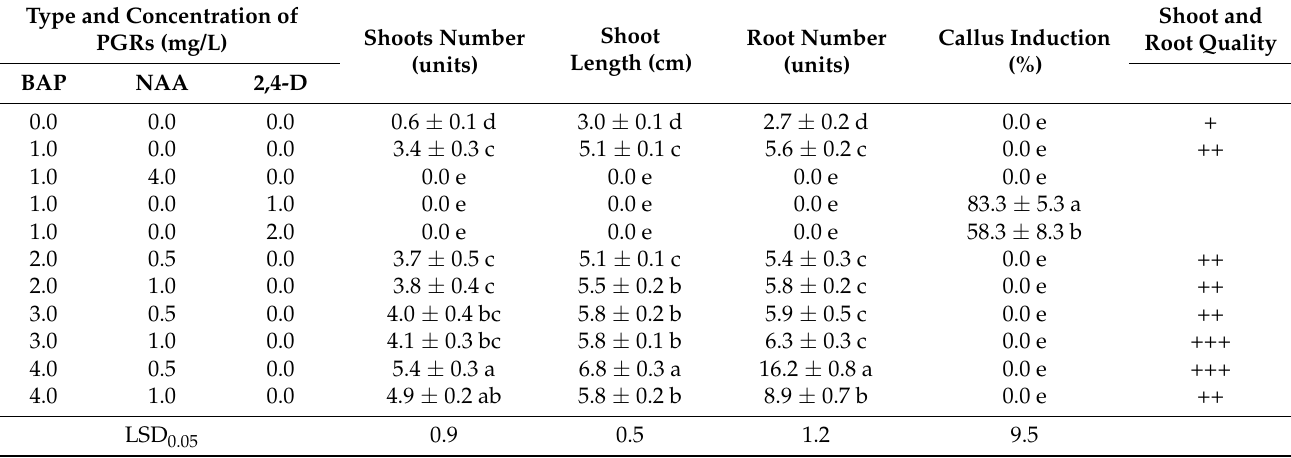
Table 3. Effect of different PGRs in MS culture medium on shoot multiplication, elongation, and rooting in black